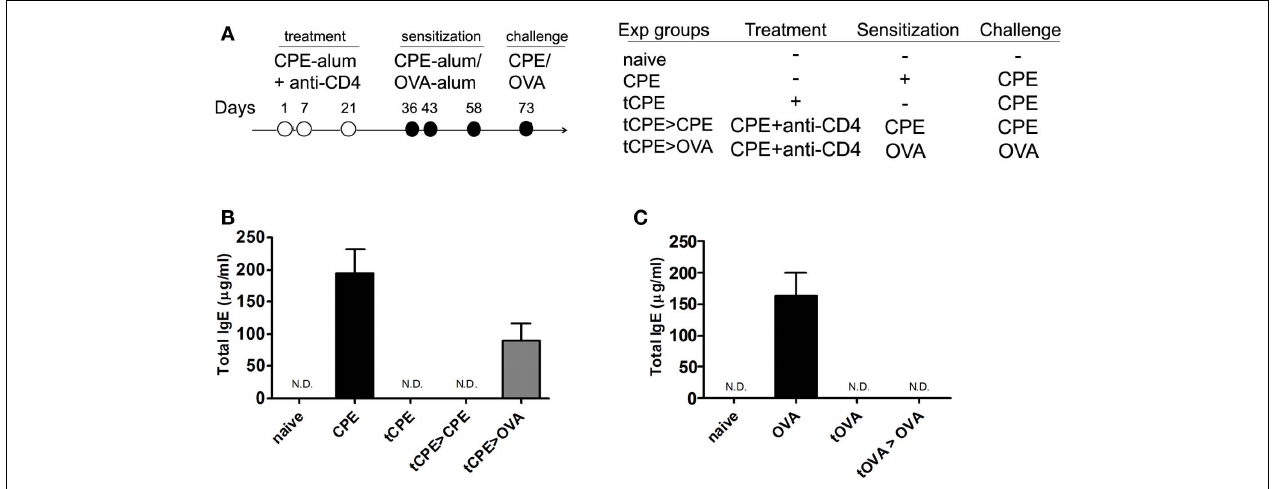
antigen (tCPE > OVA), that led to IgE titers similar to the levels of control mice (CPE). (C) Equivalent experiment to (B) where OVA was used as the antigen to sensitize C3H/HeJ mice. OVA sensitization led to high titers of IgE (OVA). Exposure to OVA in presence of CD4-blockade (tOVA) prevented IgE production even following subsequent sensitization with OVA (tOVA > OVA) ( n = 5, * P < 0.05). Data (B,C) are representative of two independent